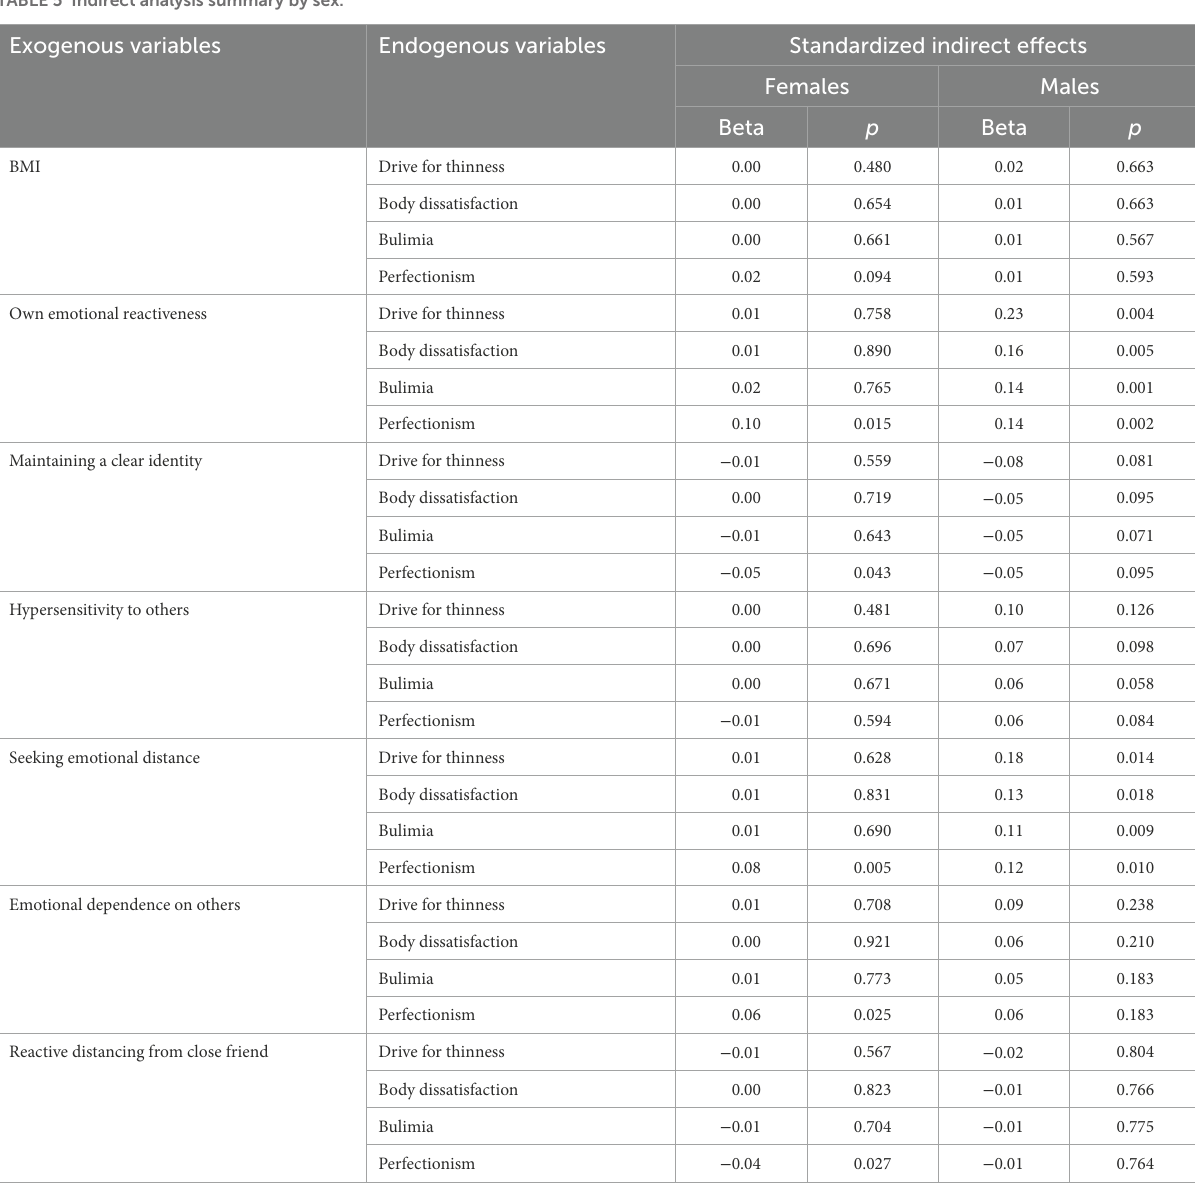
TABLE 5 Indirect analysis summary by